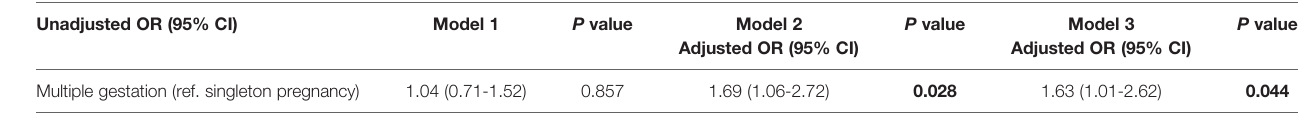
TABLE 2 | Associations between multiple gestation and PAS (N=14583).